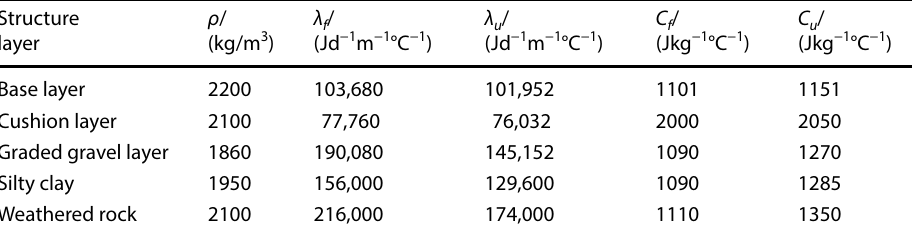
Structure layer